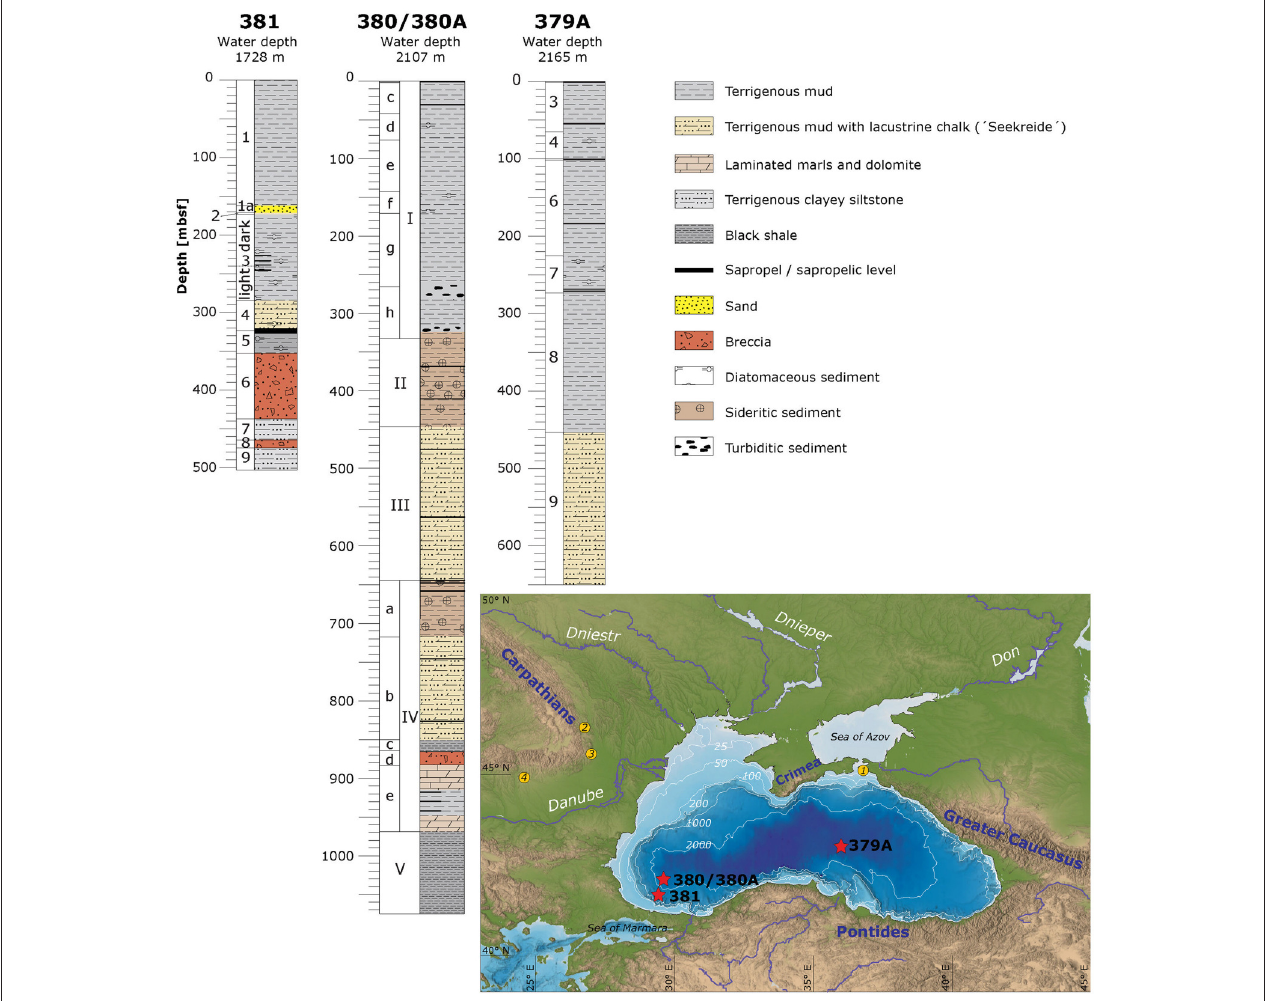
FIGURE 1 | Lithology and lithological units of DSDP leg 42B cores and map of the Black Sea region with DSDP Leg 42B drilling locations (Logs adapted from Ross, 1978b). Numbered locations indicate magnetostratigraphically dated late Miocene, Pliocene, and Pleistocene reference sections. (1) Taman Peninsula, Russia ( Krijgsman et al., 2010; Vasiliev et al., 2011), (2) Putna river, and (3) Rimnicu Sarat river (Romania; Vasiliev et al., 2004), (4) Topolog and Badislava sections (Romania; Vasiliev et al.,